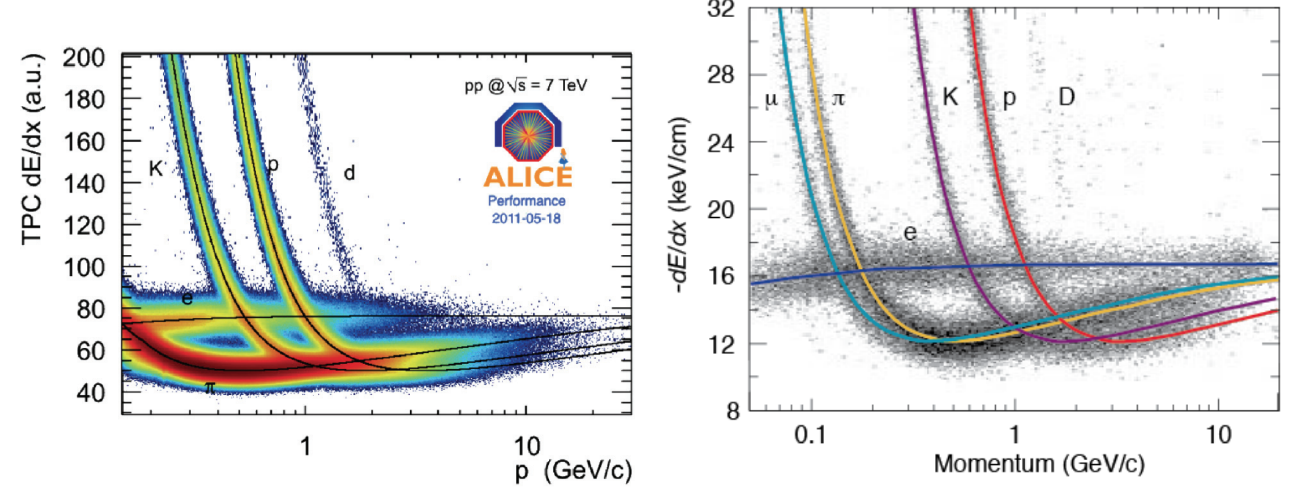
Figure 62. ( Left ): ALICE TPC dE / dx -based particle identification as a function of momentum (from [115]). ( Right ): PEP-4/9 TPC (80:20 Ar-CH4, operated at 8.5 Atm, from [114]) dE / dx -based particle